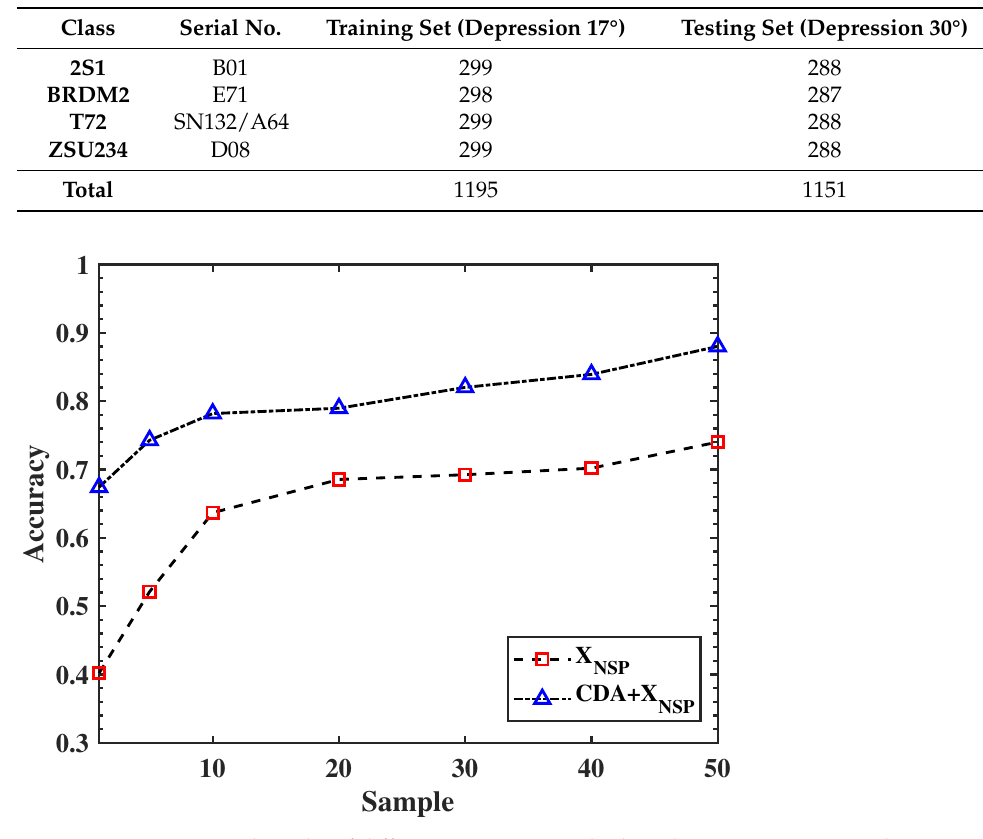
Figure 10. Experimental results of different training samples based on sparse image under EOC. Table 5. Confusion matrix of classification accuracy based on CDA and sparse SAR image via 5 samples per class.